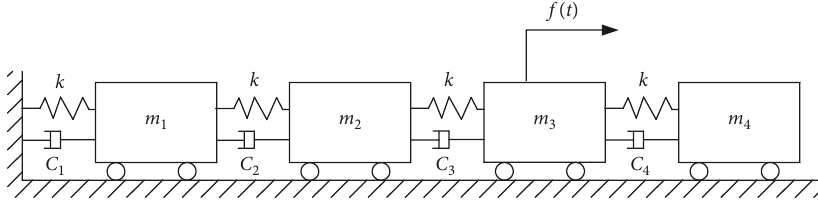
Figure 2: Four-degree-of-freedom